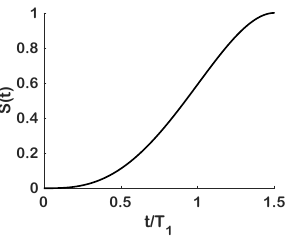
Figure 8. Sloshing force smoothing function used for the first part of the transient